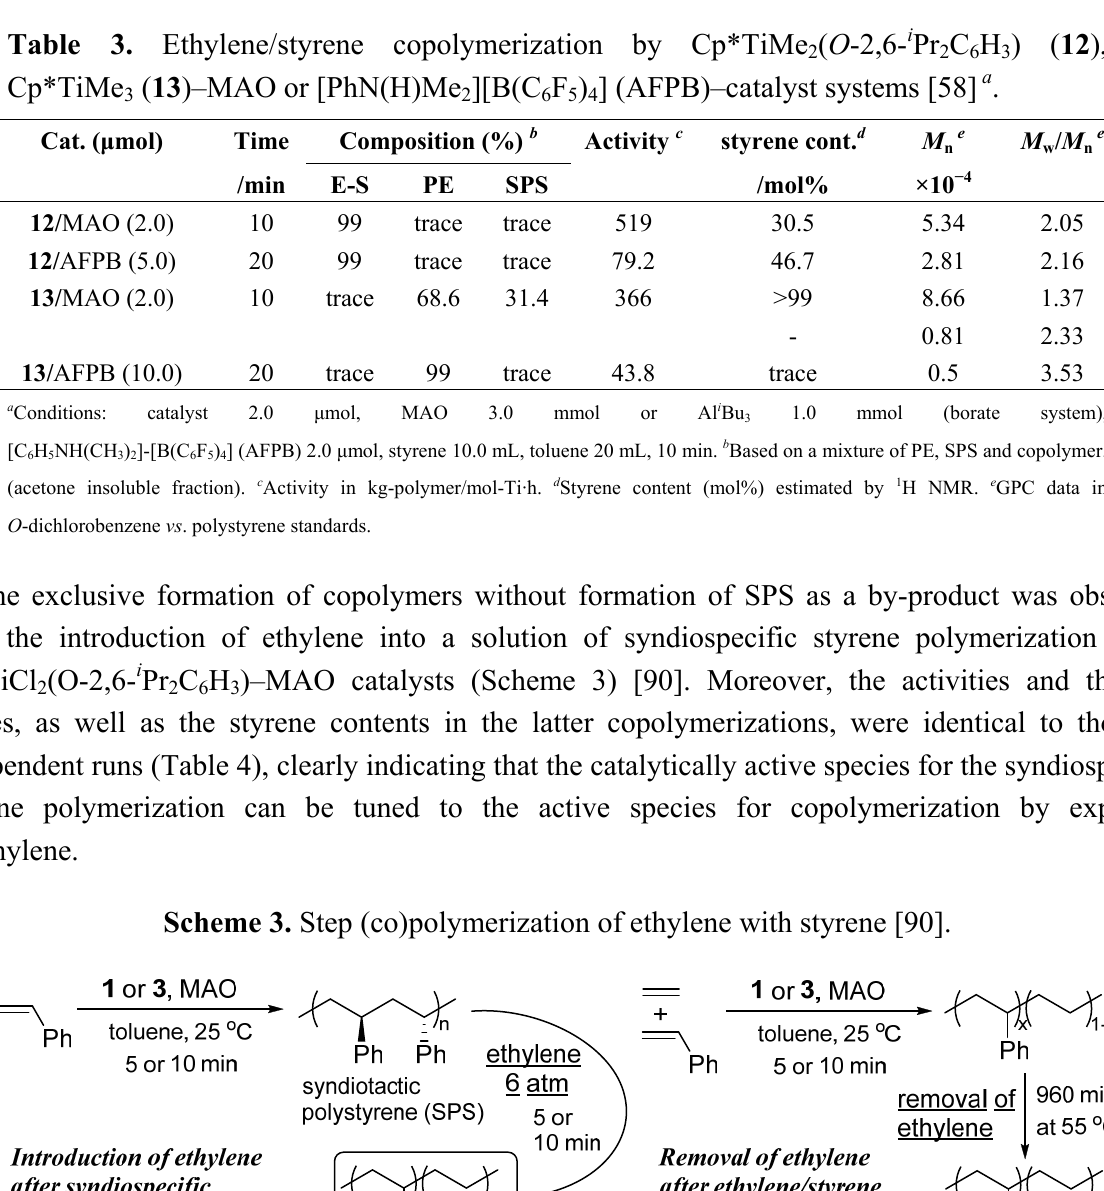
Table 3. Ethylene/styrene copolymerization by Cp*TiMe